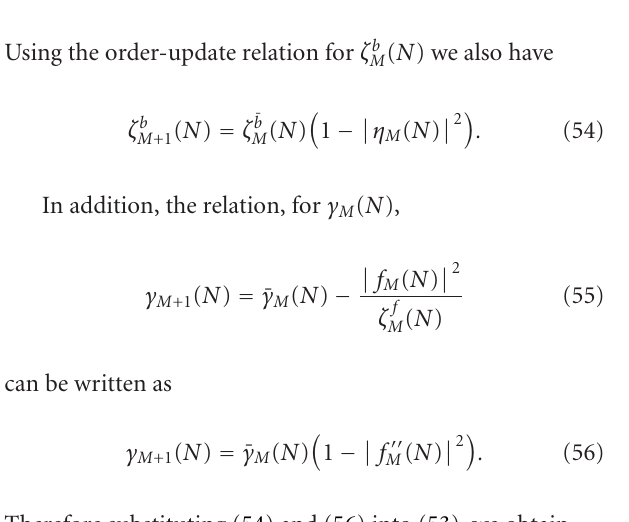
Algorithm 3: The a-posteriori-based extended RLS lattice filter with direct reflection coe ffi cients